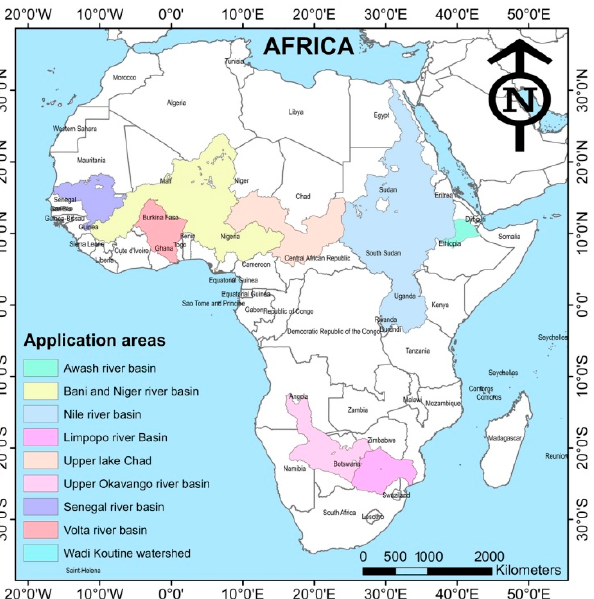
Figure 4. Application areas for studies reviewed considering water resources and streamflow sim- ulations in Africa. simulations in